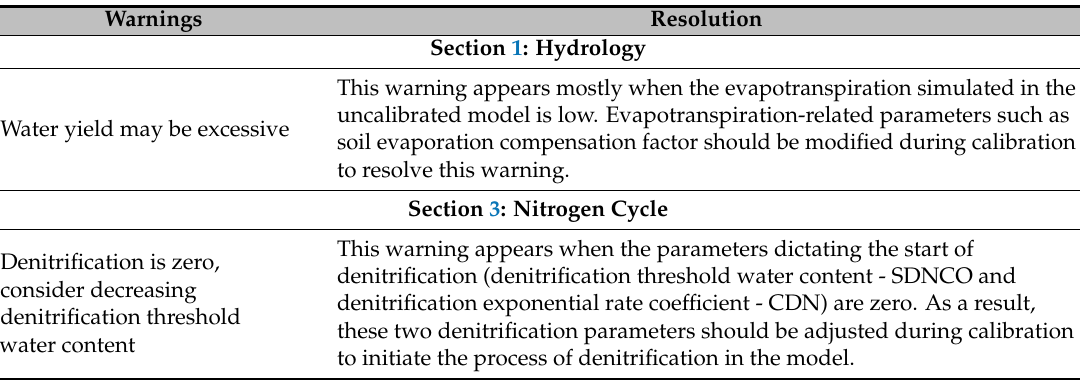
Table 5. SWAT-Check messages/warnings and potential resolution for the LRW Soil and Water Assessment Tool (SWAT)